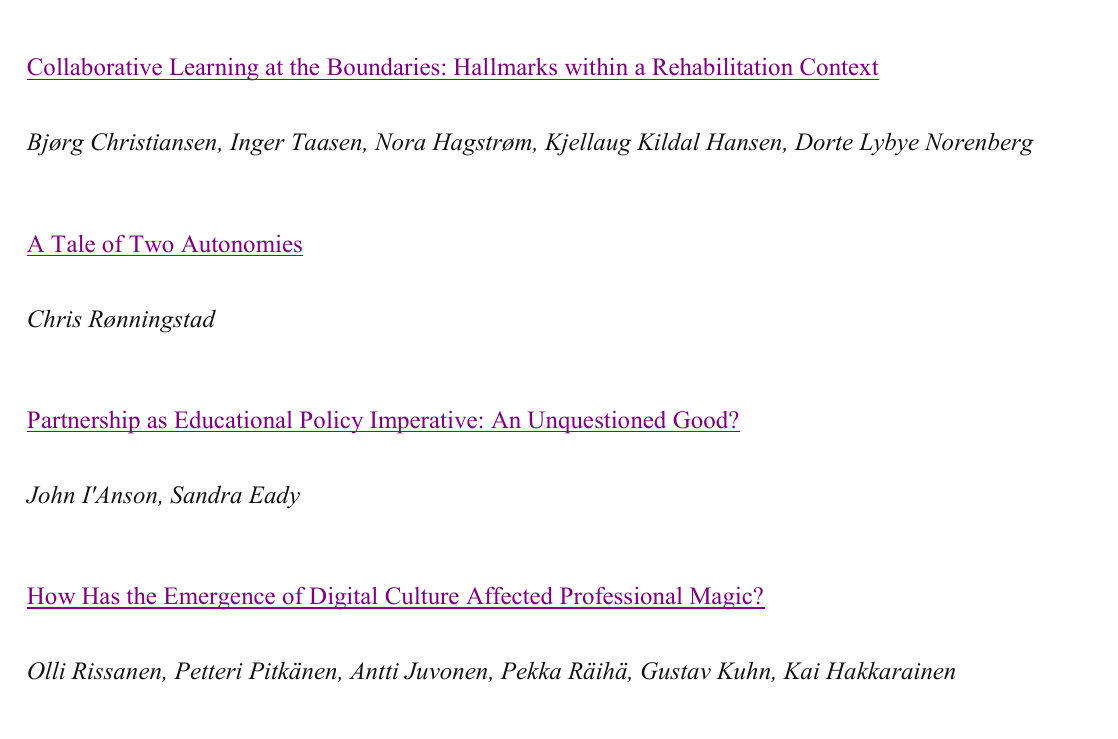
From Expert to Novice? The Influence of Management by Documents on Teachers’ Knowledge Base and Norms